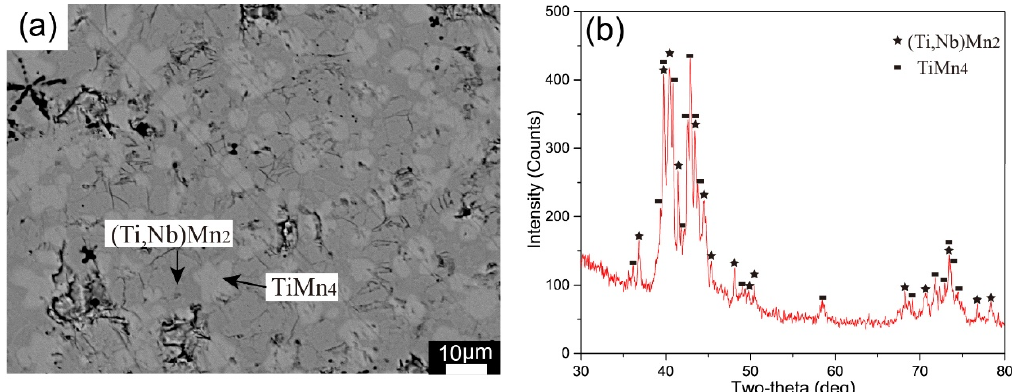
Figure 11. Alloy A12 annealed at 1173K for 90 days: ( a ) back-scattered electron (BSE) images, ( b ) XRD patterns.